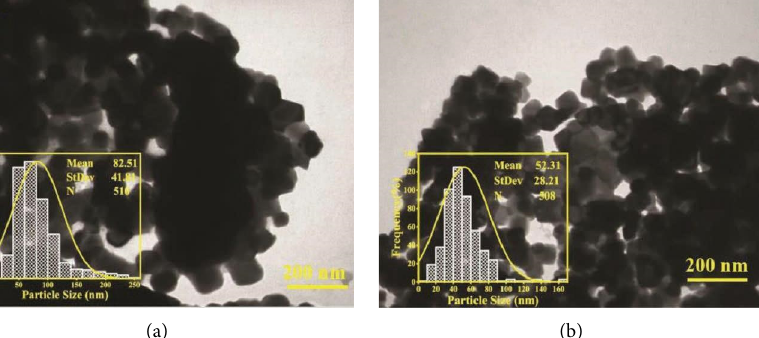
Figure 12: TEM micrographs and (inset) particle distribution histogram of the (a) CoFe samples calcinated at 800 °